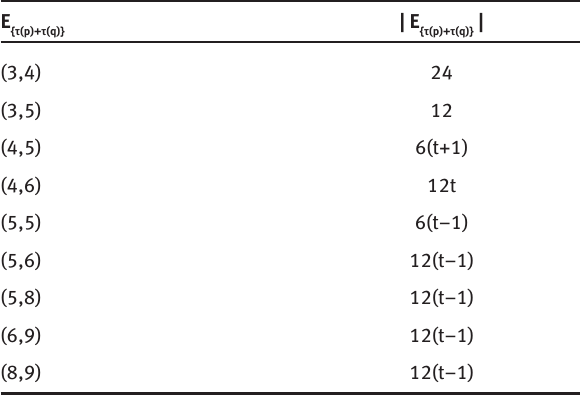
Table 8: The partation of the edges of MOF degrees addition of the leap neighbors of end